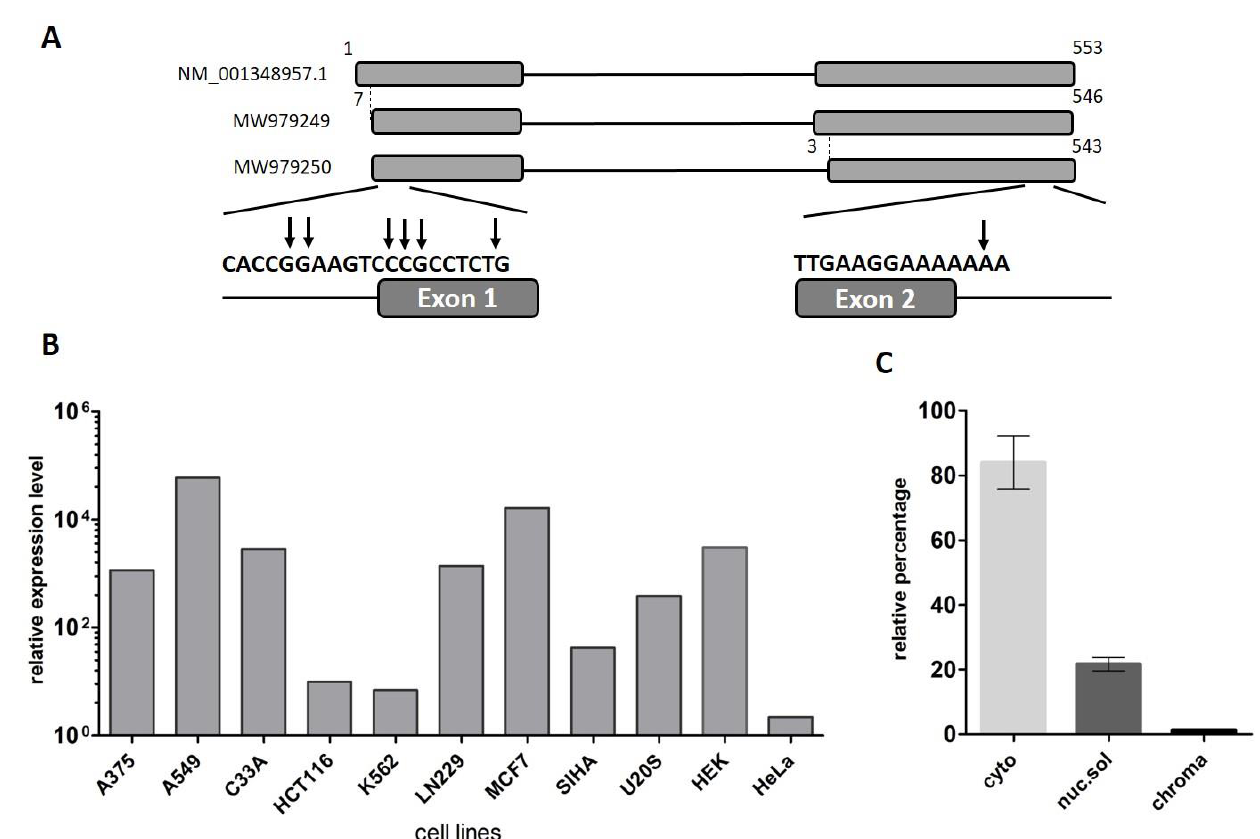
Figure 1. Analysis of the structure and expression of the LINC00493 transcript. ( A ) Scheme of the LINC00493 gene (according to RefSeq NM_001348957.1 sequence). Results of 5′ and 3′ RACE analysis are presented under the scheme. The vertical arrows represent the genomic position of exact 5′ and 3′ ends. Nucleotide numbering was based on reference sequence NM_001348957.1 ( B ) Relative expression of LINC00493 transcript in 11 human cell lines was detected by RT-qPCR. ( C ) Subcellular localization of LINC00493 was detected by qPCR of RNA isolated from cytoplasmic (cyto), nuclear-soluble (nuc.sol) and chromatin-bound (chroma) fractions of HEK293T cells. The error bars represent SEM (standard error mean).